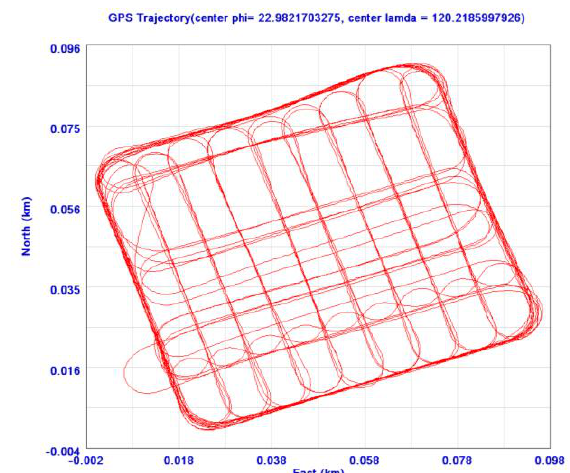
Figure 16. The trajectory of the van